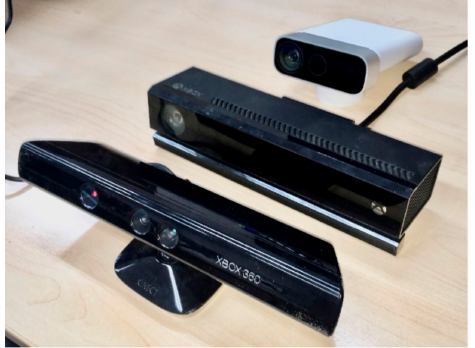
Figure 1. From left to right—Kinect v1, Kinect v2, Azure